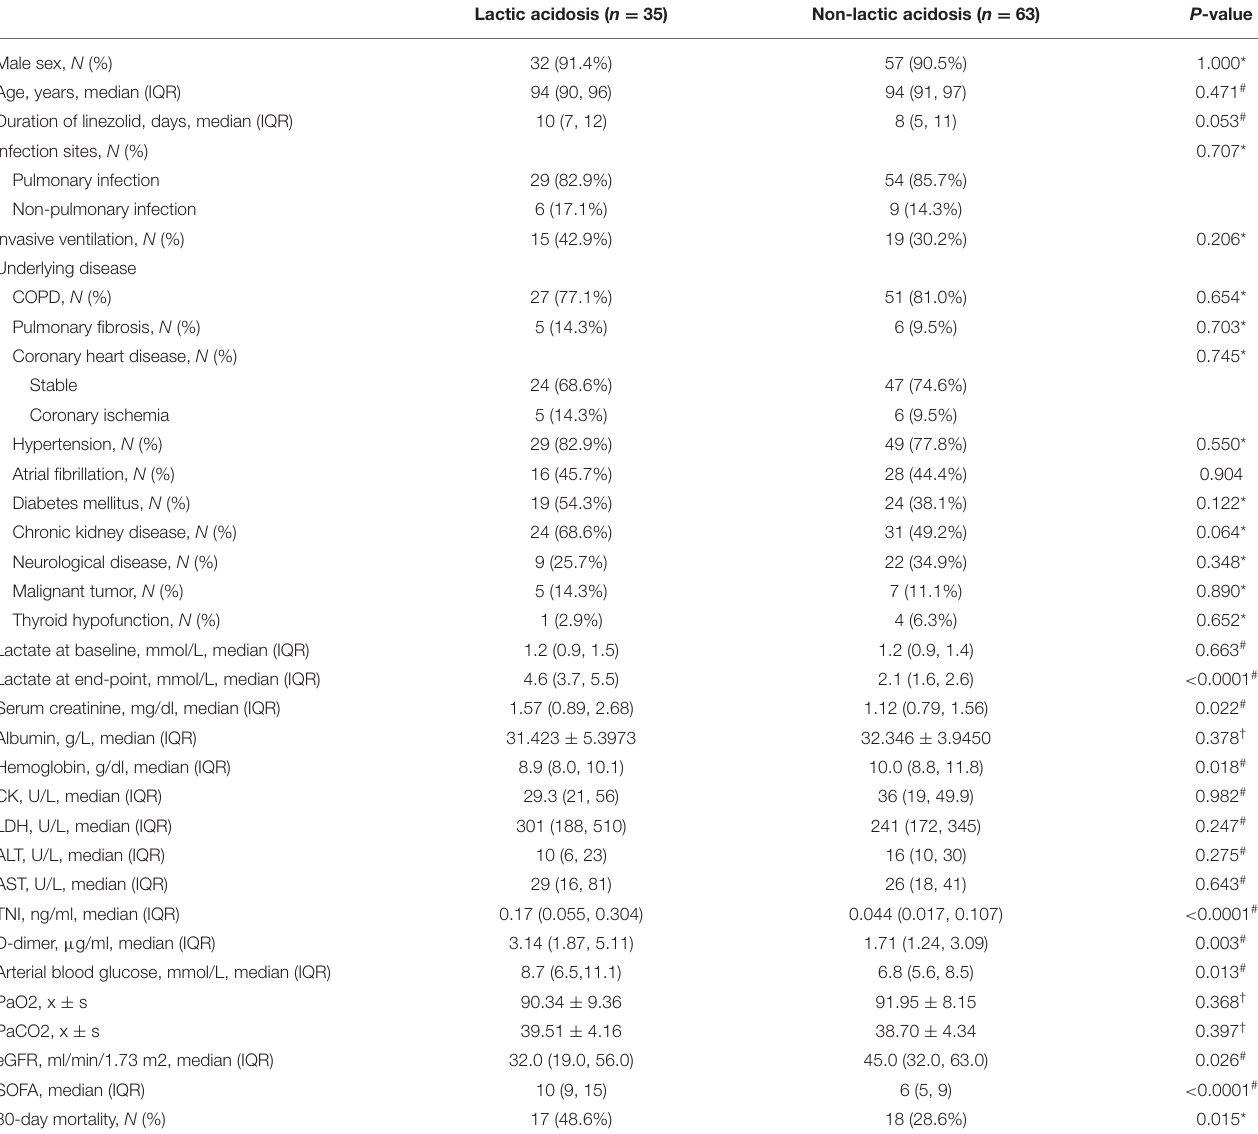
TABLE 3 | Univariate analysis of risk factors of linezolid-induced lactic acidosis. Lactic acidosis ( n = 35) Non-lactic acidosis ( n = 63) P